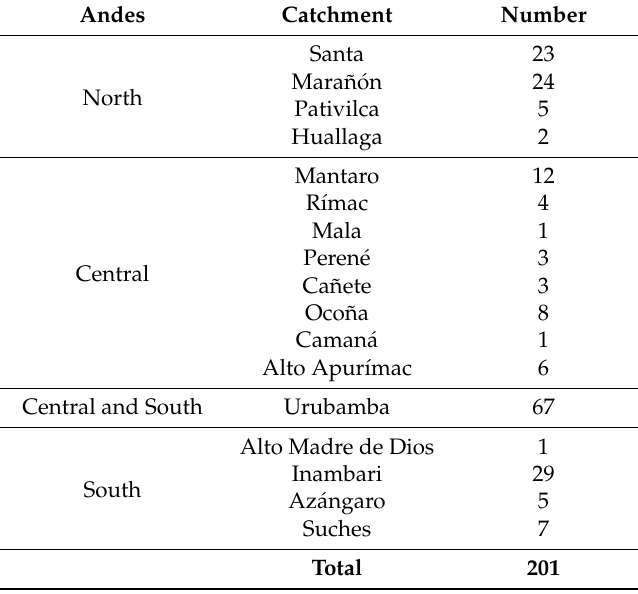
Table 1. Distribution of possible future lakes by river basins (cf. Figure 11 for corresponding information about individual Cordilleras).